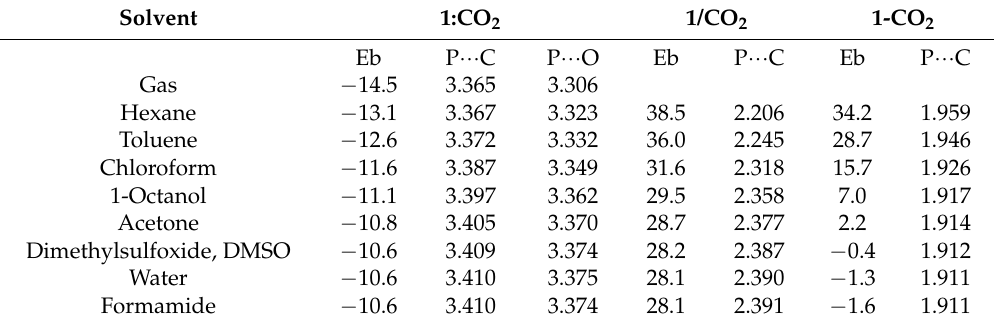
Table 1. Binding energy, Eb, (kJ · mol − 1 ) and P ··· C and P ··· O intermolecular distances (Å) of 1 + CO 2 stationary points in different solvent